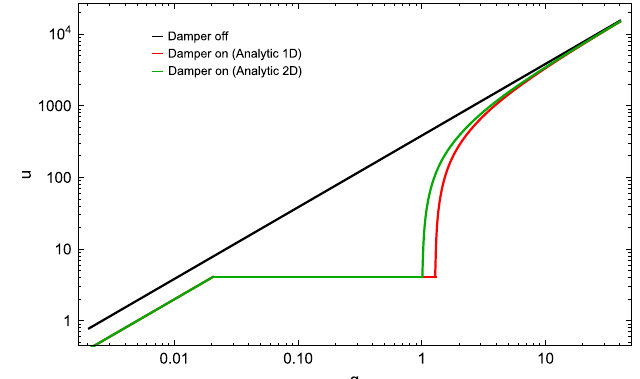
FIG. 4. Numerical evaluation of the analytic models for both 1D and 2D motion. The parameters used for evaluation: k ¼ 1 . 11 × 10 5 N=m , m ¼ 0 . 61 kg, ϵ ¼ 0 . 073 , p ¼ 0 . 34 , 1 1 ϕ ¼ 0 . 31 , ξ ¼ 0 . 0013 (determined by measurements in d 1 Sec. IV), and ξ 2 ¼ 0 . 006